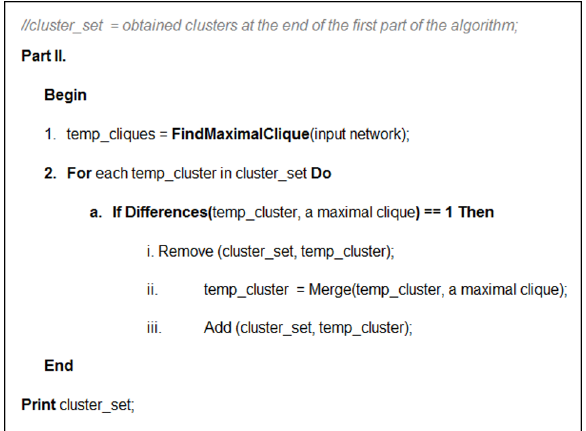
Figure 6. The pseudo code of the second part of the proposed